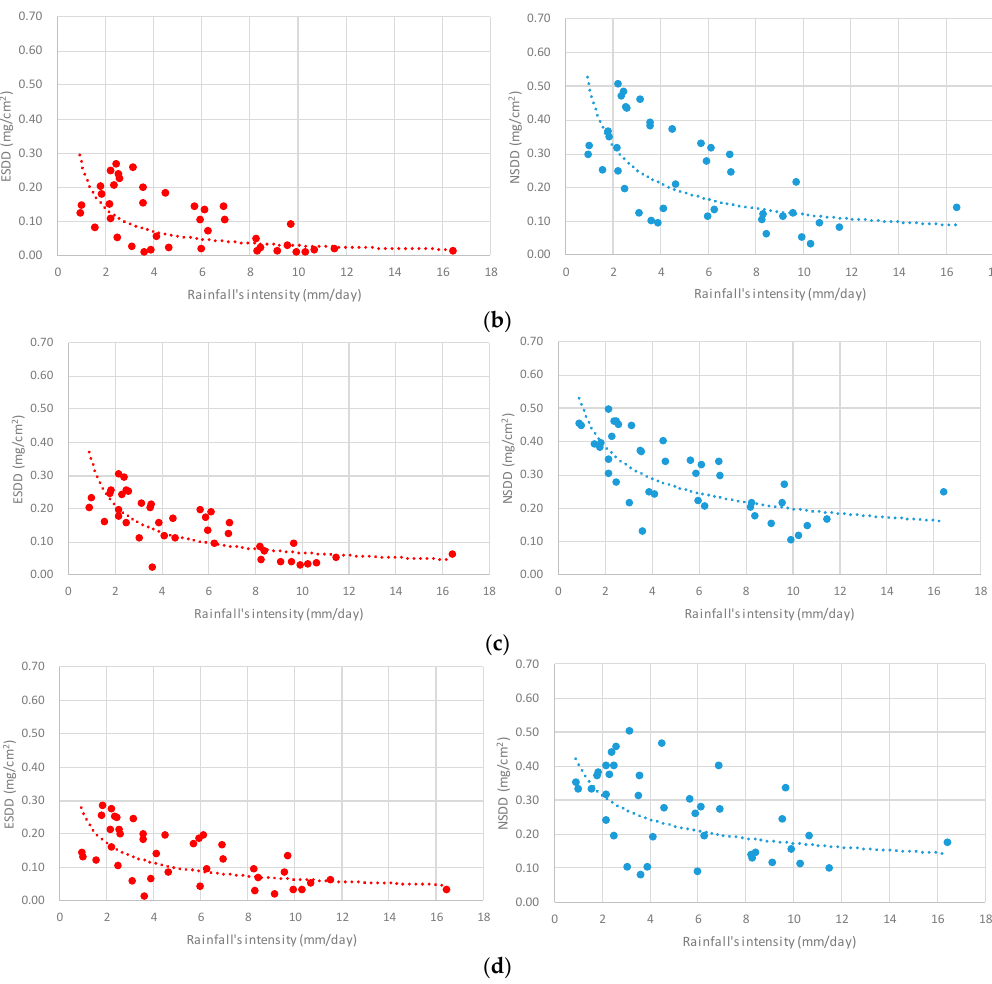
Figure 7. Residual contamination and rainfall’s intensity for all four test sites ( a ) He-Yun; ( b ) Xing-Yun; ( c ) Chuan-Gu and ( d ) Gu-Xing for 2012.